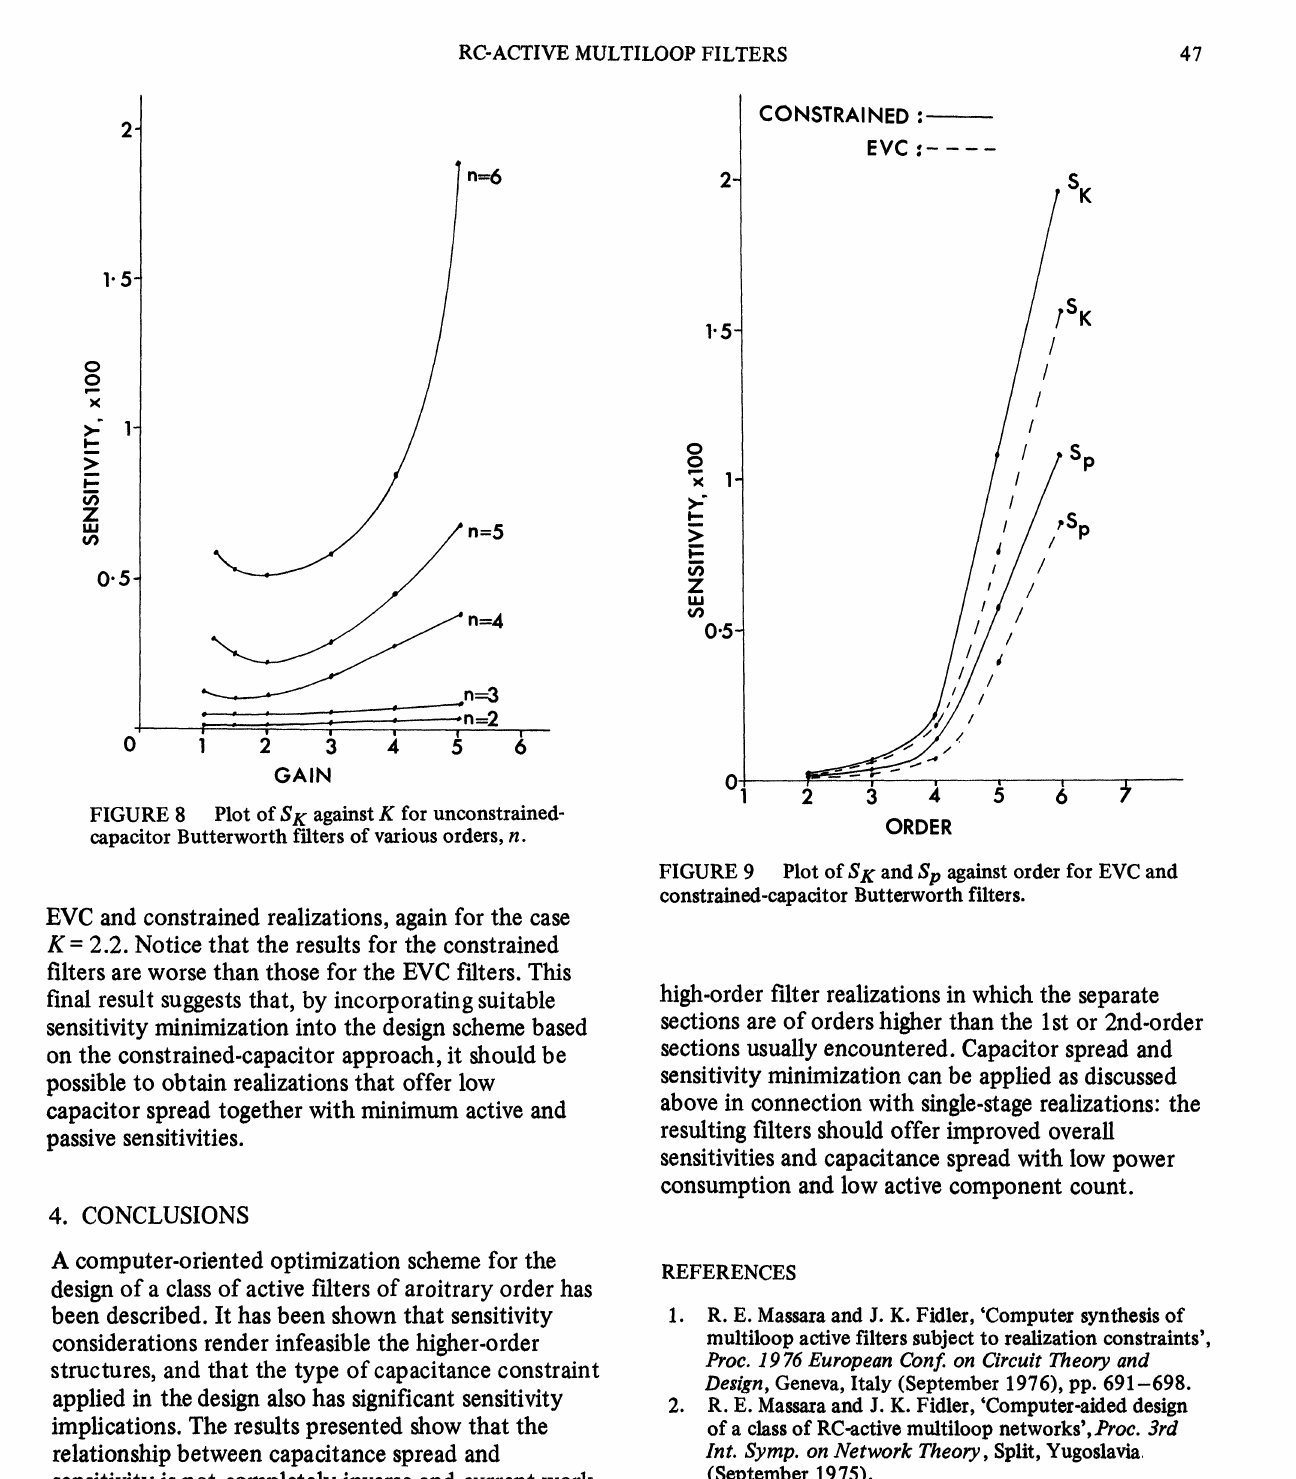
high-order filter realizations in which the separate sections are of orders higher than the 1st or 2nd-order sections usually encountered. Capacitor spread and sensitivity minimization can be applied as discussed above in connection with single-stage realizations: the resulting filters should offer improved overall sensitivities and capacitance spread with low power consumption and low active component count.